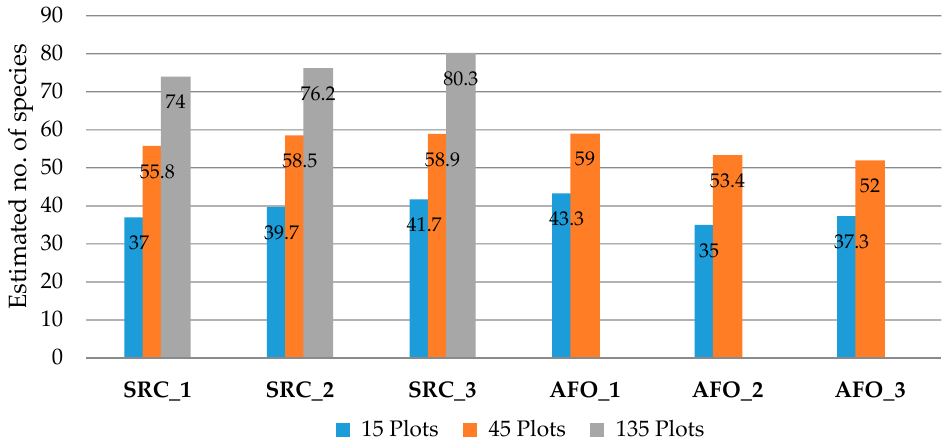
Figure 3. Estimated number of species for the different short-rotation coppice (SRC) and afforesta-